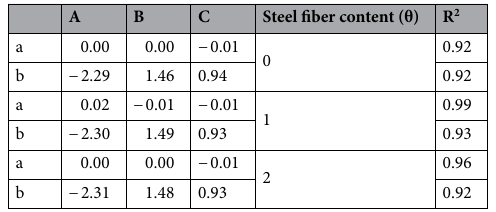
Table 6. Results of θ-value parameter analysis (relative dynamic elastic modulus